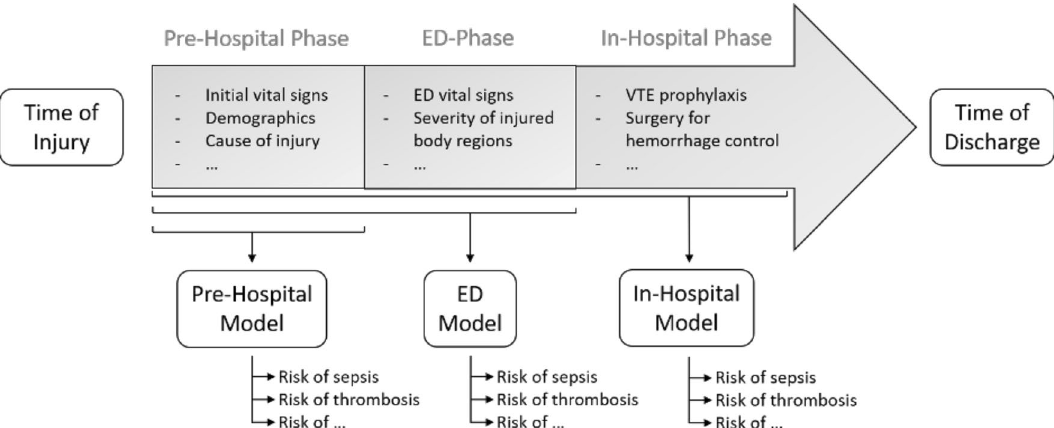
Figure 2. A graphical overview of a typical trauma patient treatment trajectory. An overview of a typical treatment trajectory for trauma patients. The timeline is divided into a time of injury, a pre-hospital phase, an emergency department (ED) phase, an in-hospital phase, and a time of discharge. As evident, an increasing amount of biomedical data becomes available, as patients pass through the trajectory. The Pre-Hospital model is trained on variables like to be available in the pre-hospital phase, such as initial vital signs at the scene of injury, demographics, and cause of injury. The ED Model includes additional input variables likely to be available early in the ED-phase, such as vital signs in the ED and the severity of each injured body region. The In-Hospital Model includes additional input variables likely to be available within the first day of hospitalization, such as the type of Venous Thromboembolism (VTE) prophylaxis and the type of surgery for hemorrhage control